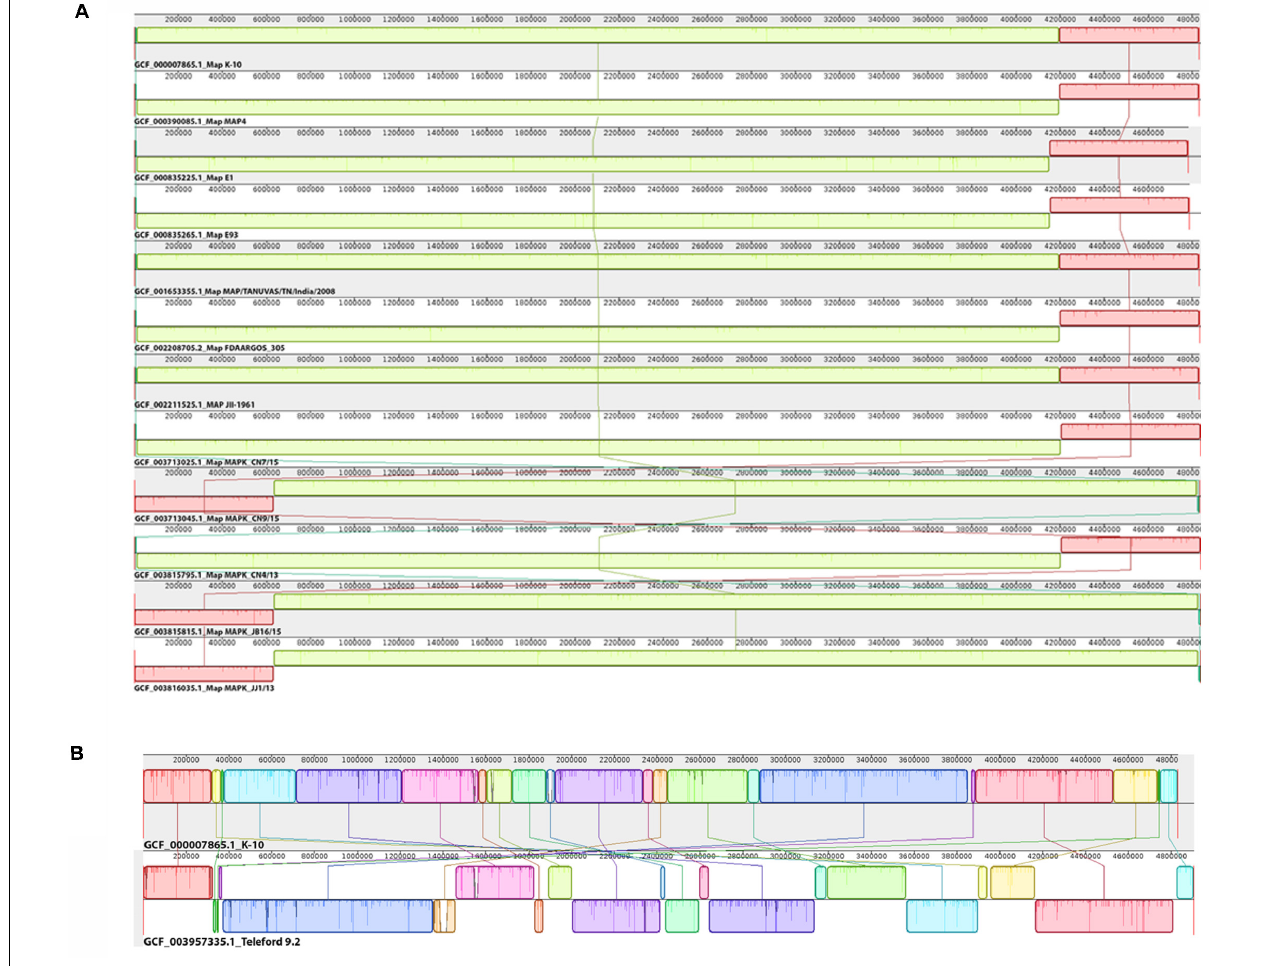
FIGURE 4 | Genomic alignment between Map strains. The 12 type II genomes (A) and the type I Telford and type II K-10 genomes (B) were all aligned relative to the dnaA gene as the anchor point. The Mauve alignment is organized into one horizontal section per input genome sequence. Each genome track contains the accession number and strain of the genome sequence along with a base pair scale showing the sequence coordinates for that genome. Blocks of various colors above and beneath the center line represent defined genome regions. Similar colored blocks in different genomes represent regions that aligned in each genome. When a block lies above the center line the aligned region is in the forward orientation relative to the K-10 genome sequence (top). Blocks below the center line indicate regions that align in the reverse complement (inverse)